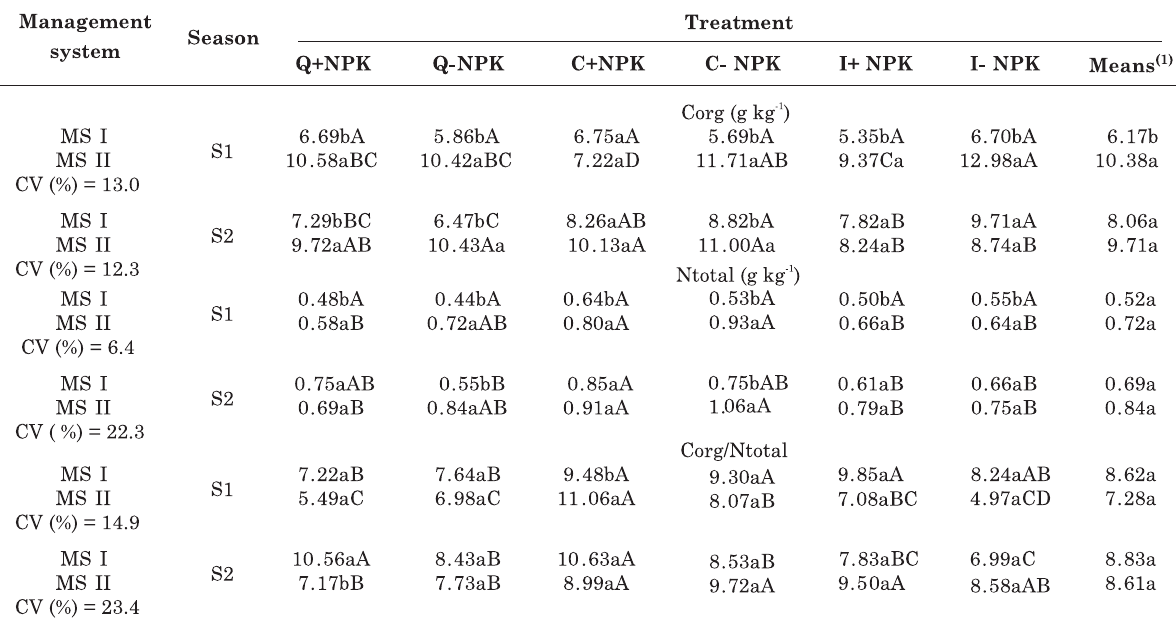
Table 2. Organic carbon (Corg), N total and ratio of Corg/Ntotal in two land use systems, under